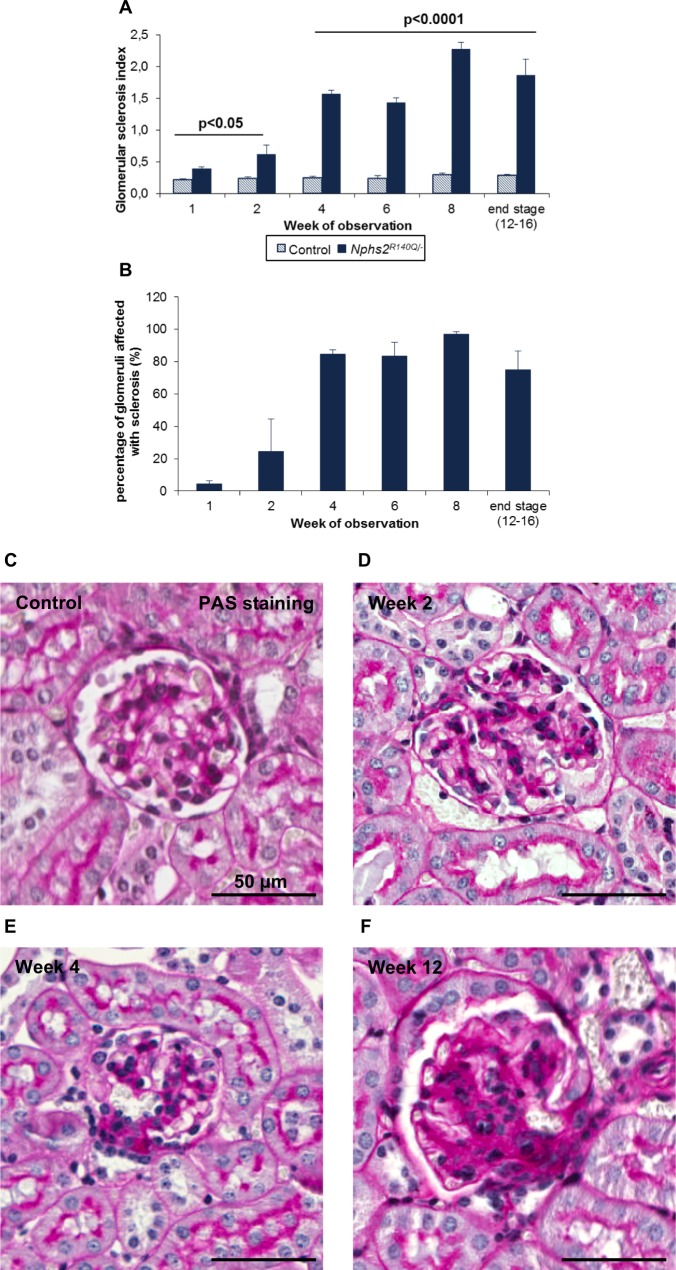
Nphs2R140Q/- mice develop focal-segmental glomerulosclerosis (FSGS).(A) Glomerular sclerosis index (GSI) in healthy and Nphs2R140Q/- mice. (B) Percentage of glomeruli affected by sclerosis in Nphs2R140Q/- mice increased drastically over time (columns represent 4–10 animals per group and time point). (C-F) Evolution of glomerular lesions in induced animals. PAS staining; Magnification, X200.